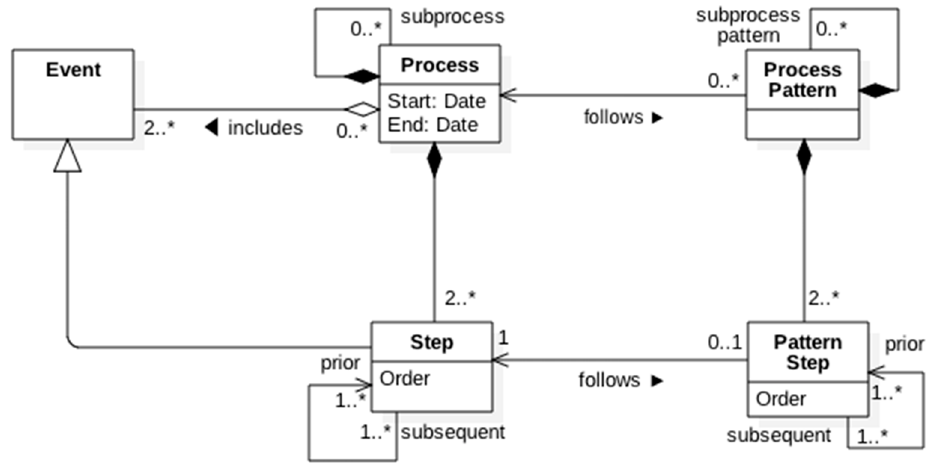
Figure 4. Event and Process. An Event may be part of a Process, which is a set of related Events. When it is, it is called a Step. A Process may follow a Process Pattern. When it does, the Steps in the actual Process may correspond to Pattern Steps in the Process Pattern; however, there may be actual steps in addition to those indicated in the Process